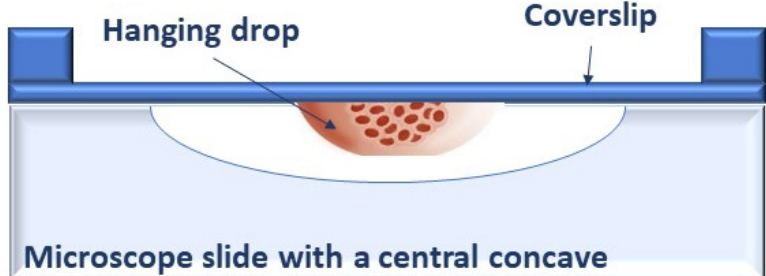
Figure 1. Schematic diagram of the hanging drop technique proposed for the first time by Harrison in 1907 [3]. In this method, a droplet of medium containing suspended cells (shown as dark red spots) is placed on a coverslip that is inverted to allow the falling of the drop in the concave well of the microscope slide. Cells aggregate due to gravitational forces and finally form sphe- roids.